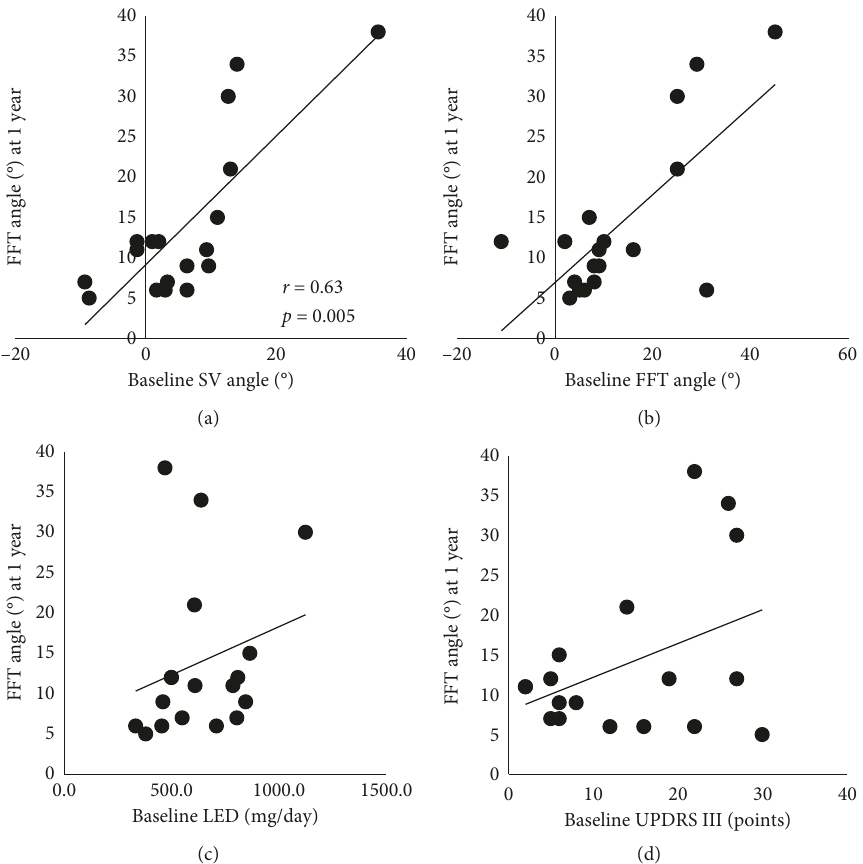
Figure 2: Regression lines showing the relationships between the 1-year FFT angle and (a) baseline SV angle, (b) baseline FFT angle, (c) baseline LED, and (d) baseline UPDRS III score (D). SV, subjective vertical position; FFT, forward flexion of trunk; LED, levodopa- equivalent dose; UPDRS, Unified Parkinson’s Disease Rating